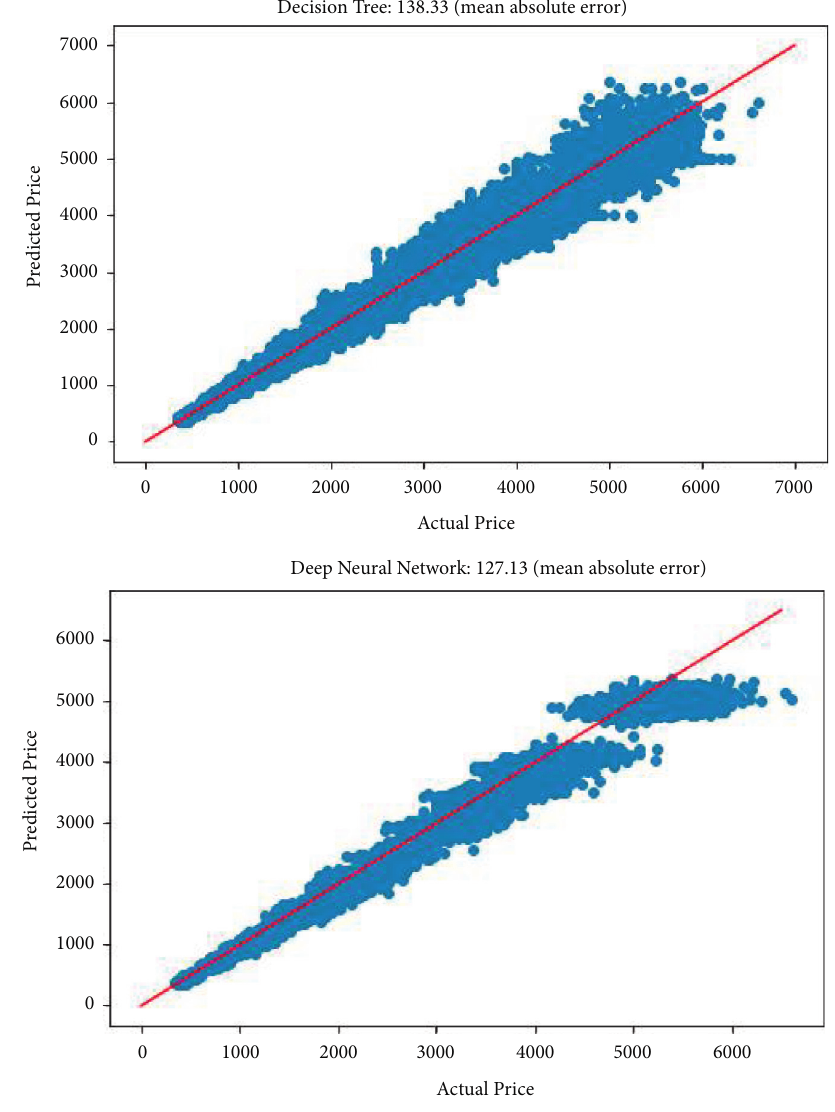
Figure 14: Comparative analysis of the machine learning